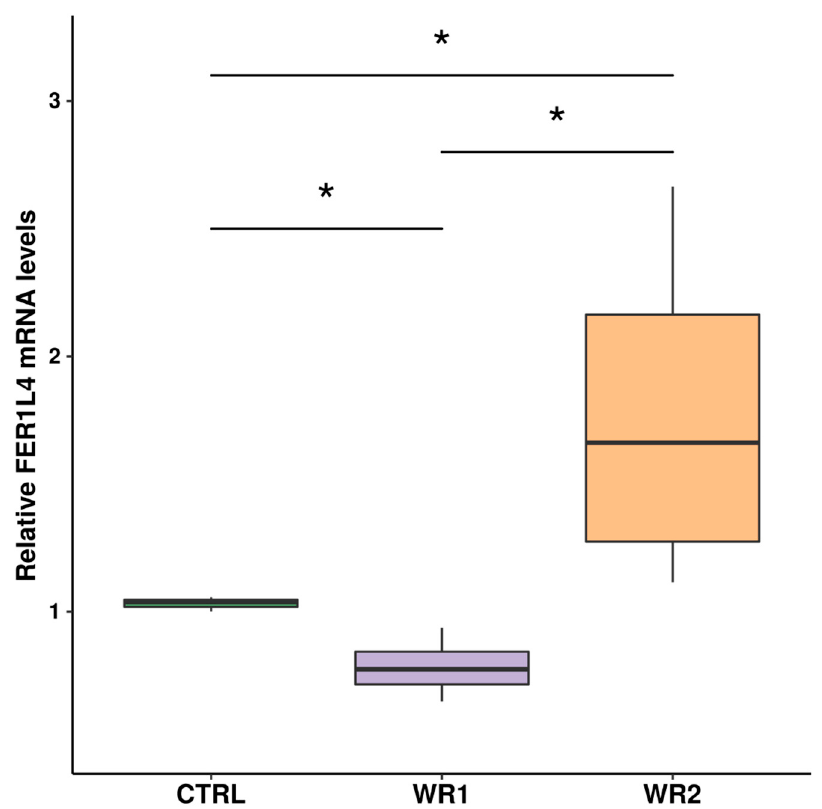
Figure 4. Expression of FER1L4 measured by RT-qPCR in experimental conditions after 24 h of co-culture. (* p < 0.05 by Kruskal–Wallis test). Table 3. The top 10 KEGG pathways enriched by the target genes of 27 micro RNAs (miRNAs) with experimentally supported interaction with